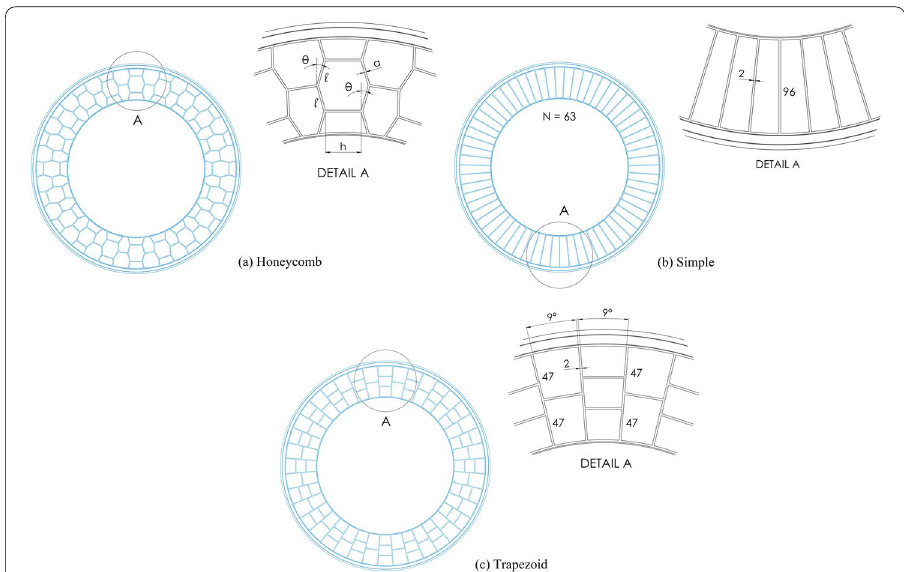
Fig. 2 Geometrical and schematic pictures of spoke